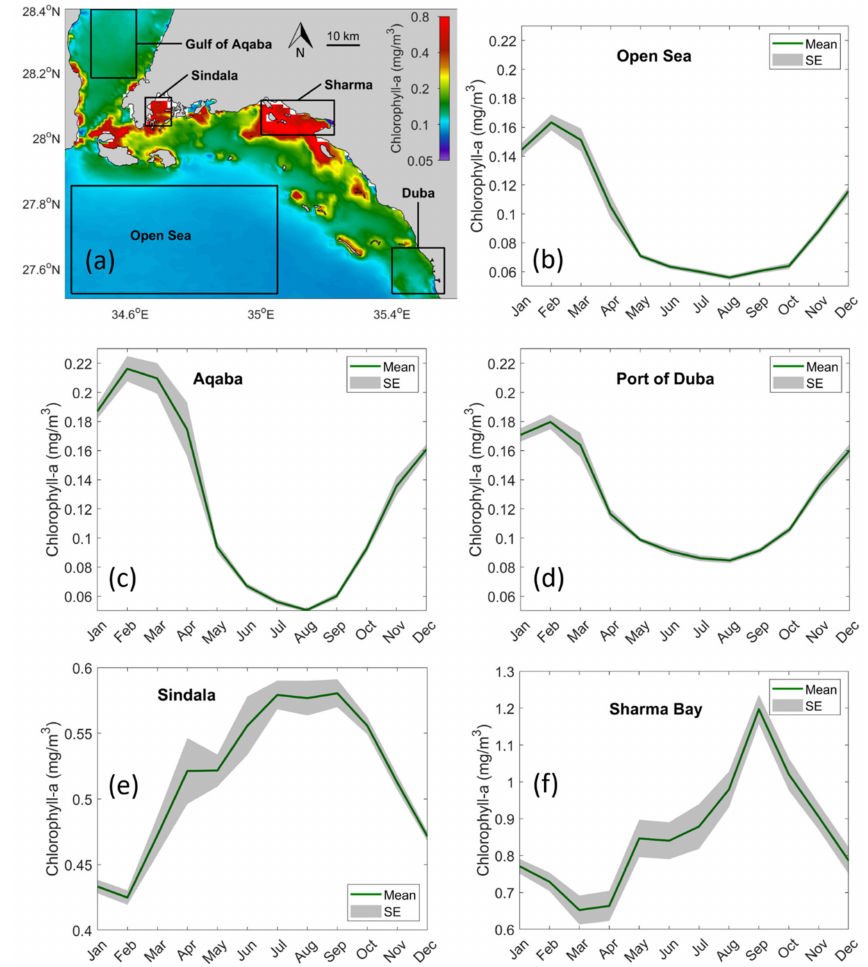
Figure 3. Climatology of Chl-a in the NEOM region based on 21 years of satellite observations (1997–2018). In panel ( a ) the overall climatology of the region is plotted spatially along with the areas examined in this study. The bounding box for each area is also highlighted on the map. The seasonal climatology of Chl-a concentration (mg/m 3 ) is presented for: ( b ) the open sea, ( c ) the Gulf of Aqaba, ( d ), the Port of Duba, ( e ) Sindala and ( f ) Sharma Bay. Note that the time-series plots for Sindala and Sharma have different y -axis scales, to account for the higher Chl-a concentrations observed there, and highlight their seasonal